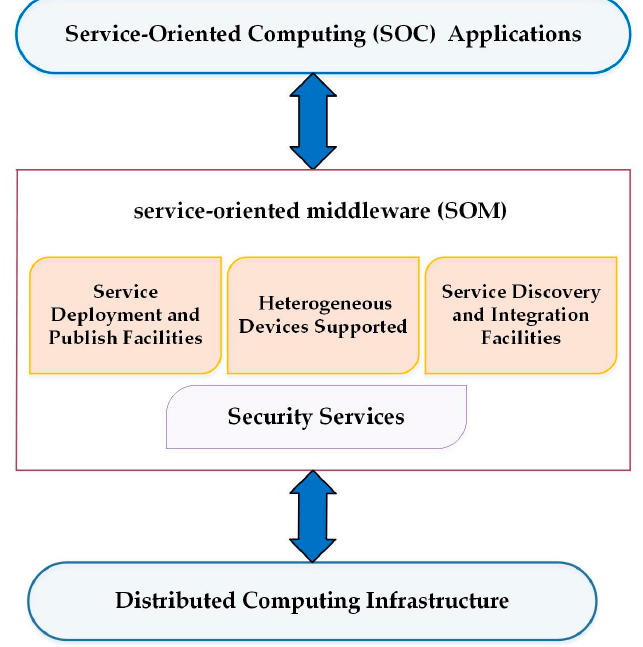
Figure 13. Generic Security SOM Architecture Framework [26].